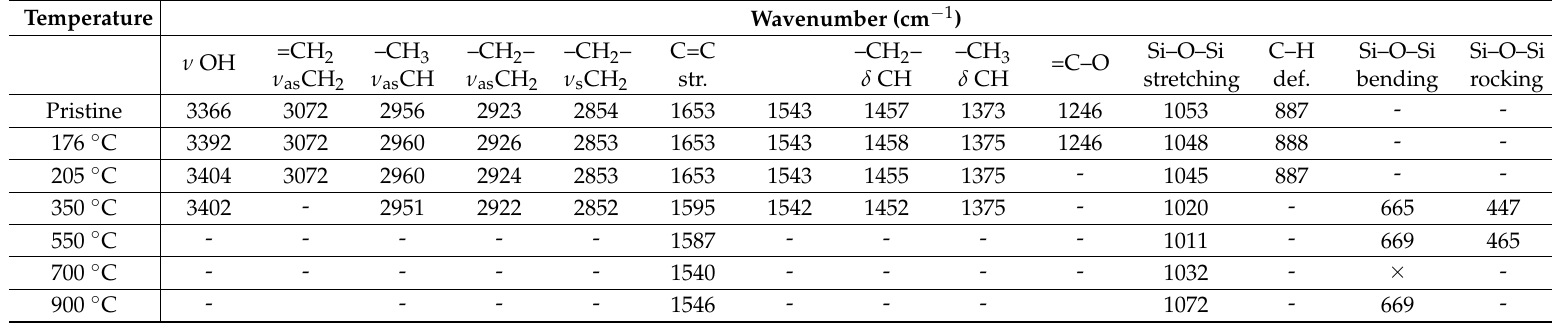
Table 1. Infrared (IR) absorptions of B. braunii residue before and after